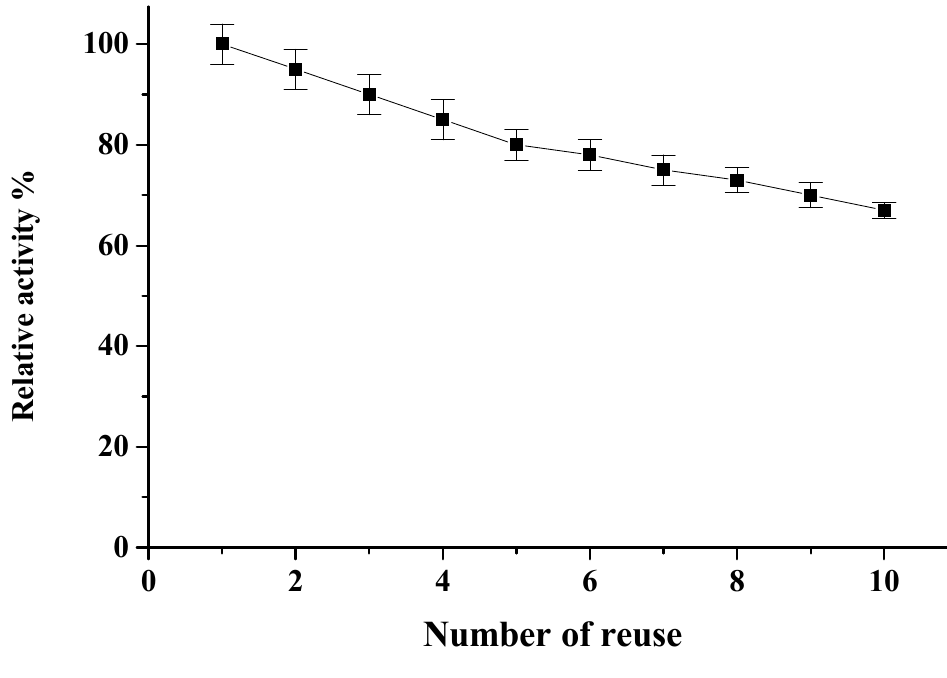
Figure 3. Reuse of immobilized catalase in assay. The solid supports for enzyme immobilization could have a large multi-crosslinkings, which maintained the structure of enzyme from any change of pH and temperature [41,42]. This immobilization effect can also be manifested by studying the influne of pH on its activity compared with its free form. Thus, the assessment was made pH’s 4.0–8.5 (Figure 4). The pH was changed from 6.5 for free form to broad pH at 6.5–7.0 for immobilized form. The free catalase and immobilized on bentonite-cysteine (Bent-Cys) microcomposite had optimum pH at 7.0 [43] and increased to pH 7.5 using chitosan/ZnO/Fe 2 O 3 nanocomposite [27].